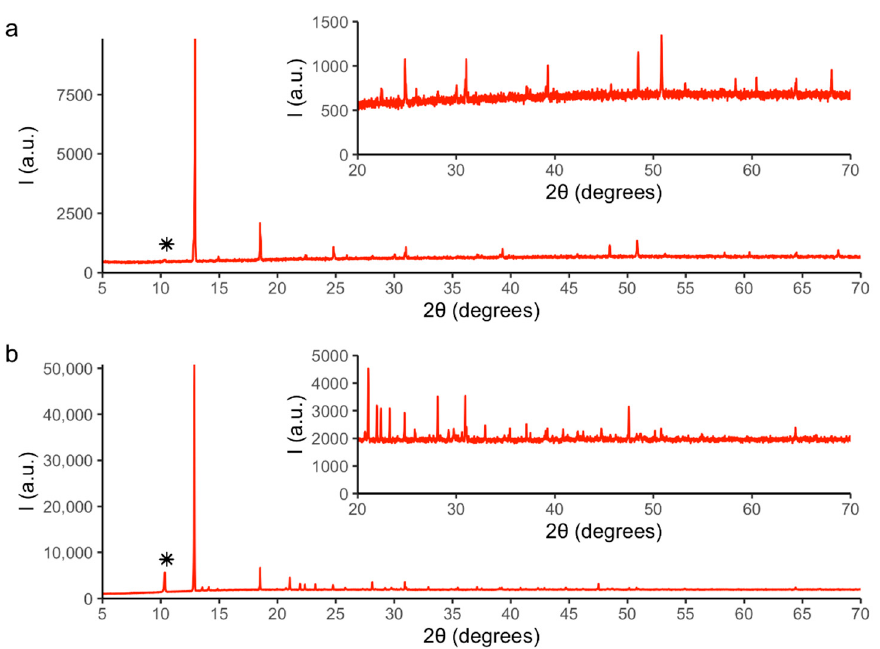
Figure 1. X-ray powder diffractograms of commercial cobalt acetate tetrahydrate before ( a ) and ( b ) after grinding. The most intense reflection of the dihydrated cobalt acetate (marked with an asterisk in the figures) is visible in both diagrams, although its intensity is clearly increased in the ground sample. An enlargement of both diffraction patterns is shown at the inset.